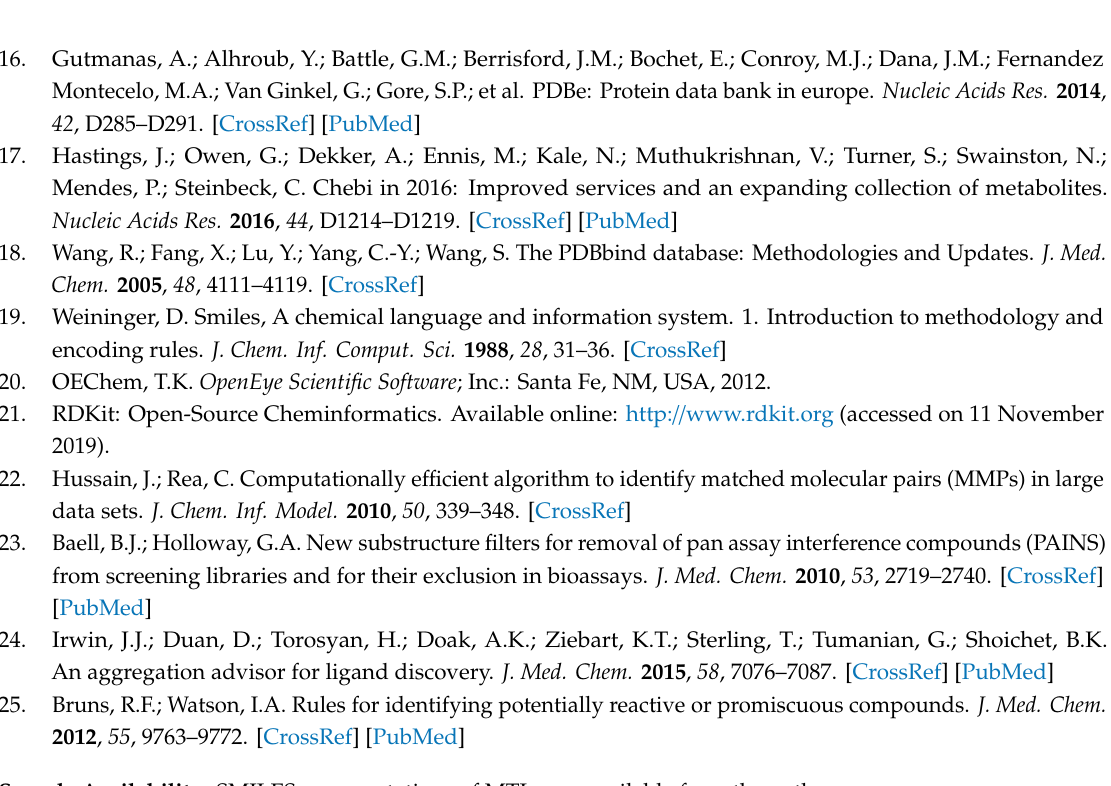
Sample Availability: SMILES representations of MTLs are available from the